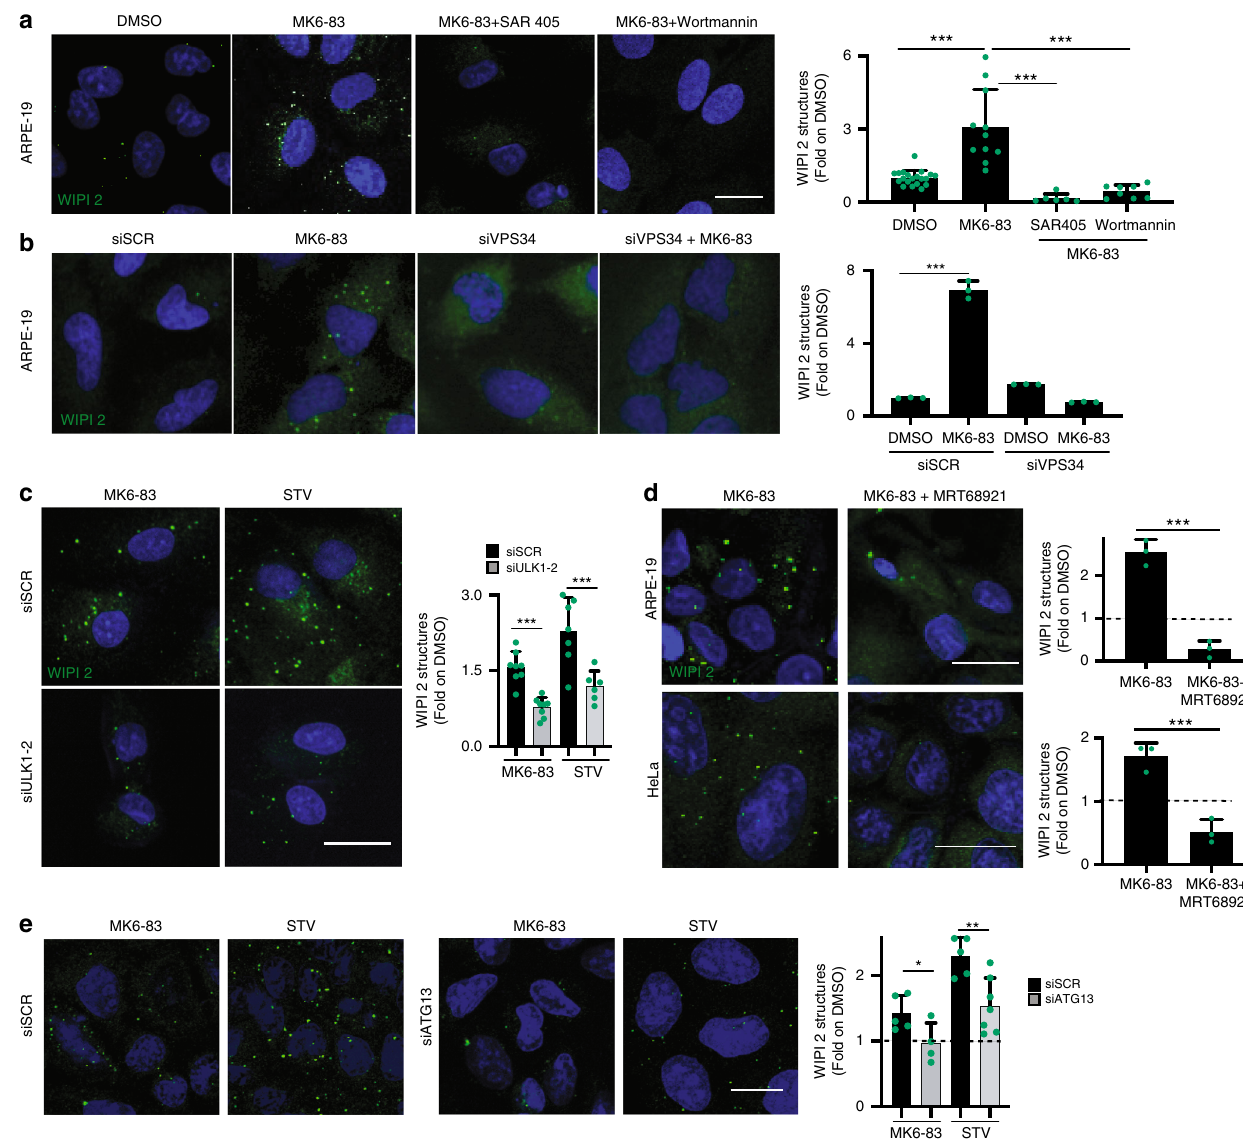
Fig. 3 PI3P generation through TRPML1 requires both hVPS34 and ULK1. a Representative confocal images of endogenous WIPI2 in ARPE-19 cells treated with DMSO and MK6-83 alone or in combination with SAR405 or wortmannin. Plot shows the quanti fi cation of WIPI2 puncta as fold induction to DMSO-treated cells. Values are means ± SD of n > 1000 cells pooled from three independent experiments. b Representative images from high-content assay of endogenous WIPI2 in ARPE-19 cells treated with a pool of three siRNA targeting VPS34 (siVPS34) or a scramble sequence. Values are means ± SD of n = 200 cells pooled from three independent experiments. c Representative images from cell-based high-content imaging assay of endogenous WIPI2 in ARPE-19 cells silenced with siRNA molecules targeting ULK1 and ULK2, followed by treatment with MK6-83 or STV (HBSS). Plot shows the quanti fi cation of WIPI2 puncta as fold induction to DMSO-treated cells. Values are means ± SD of n > 1000 cells pooled from three independent experiments. d Representative confocal images of endogenous WIPI2 in ARPE-19 and HeLa cells treated with MK6-83 alone or in combination with the ULK1 inhibitor (MRT-68921). Plots show the quanti fi cation of WIPI2 puncta as fold to DMSO. Values are means± SD of n > 1000 cells pooled from four independent experiments. e Representative confocal images of endogenous WIPI2 in HeLa cells silenced with a pool of three siRNA molecules targeting ATG13 (siATG13) followed by treatment with MK6-83 or STV (HBSS). Plot shows the quanti fi cation of WIPI2 puncta as fold induction to DMSO-treated cells. Values are means± SD of n > 1000 cells pooled from three independent experiments. P -values calculated by two tails Student ’ s t -test. Scale bar: 20 µ m. * p -value < 0.05; ** p -value < 0.01; *** p -value <